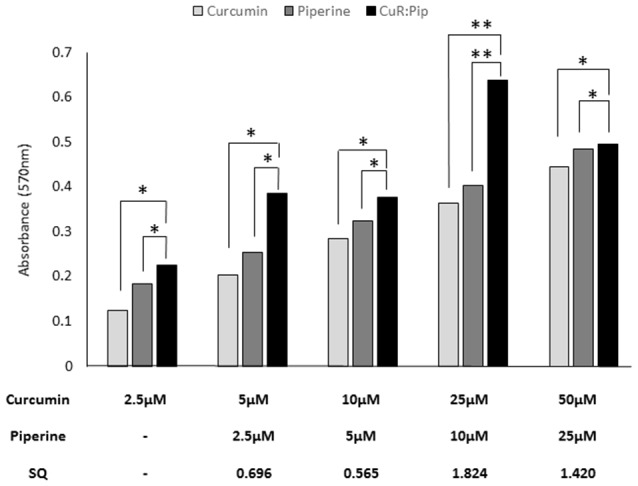
Effect of varying concentrations of curcumin and piperine used in combination in SH-SY5Y cells proliferation after 24 h. Synergism quotient (SQ) values were calculated to determine if there was any synergistic activity in the treatment. The results presented are averages of three independent experiments each done in triplicate and expressed as the mean ± SEM. *p < 0.05, **p < 0.01, one-way ANOVA with Dunnett’s test compared to combined curcumin and piperine group (CuR: Pip).